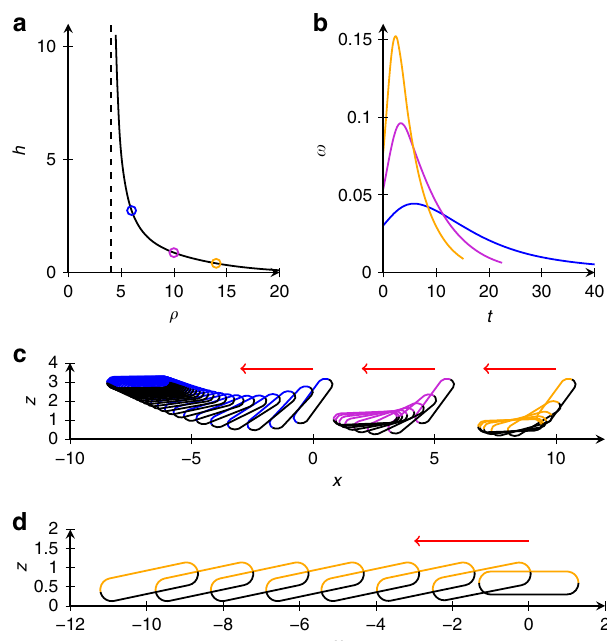
Fig. 8 Simulated dynamics of tori over a plane boundary. a The height h at which the base of a torus with unit activity and mobility hovers over the plane boundary as a function of its added density ρ (where ρ ¼ 0 is neutrally buoyant). The asymptote ρ ¼ 4 : 33 is the density at which such a torus in free space neither sinks nor swims. b The relaxation to a stable horizontal hovering state of uncharged tori, showing decaying angular velocity ω with time. c Swimmer trajectories with equal intervals of uncharged tori. d Transition from horizontal to steady gliding state (at a 12 (cid:4) angle) of a charged torus. Red arrows indicate progression of time. Here the major and minor radii of the tori a 1 ¼ 1 ; a 2 ¼ 0 :